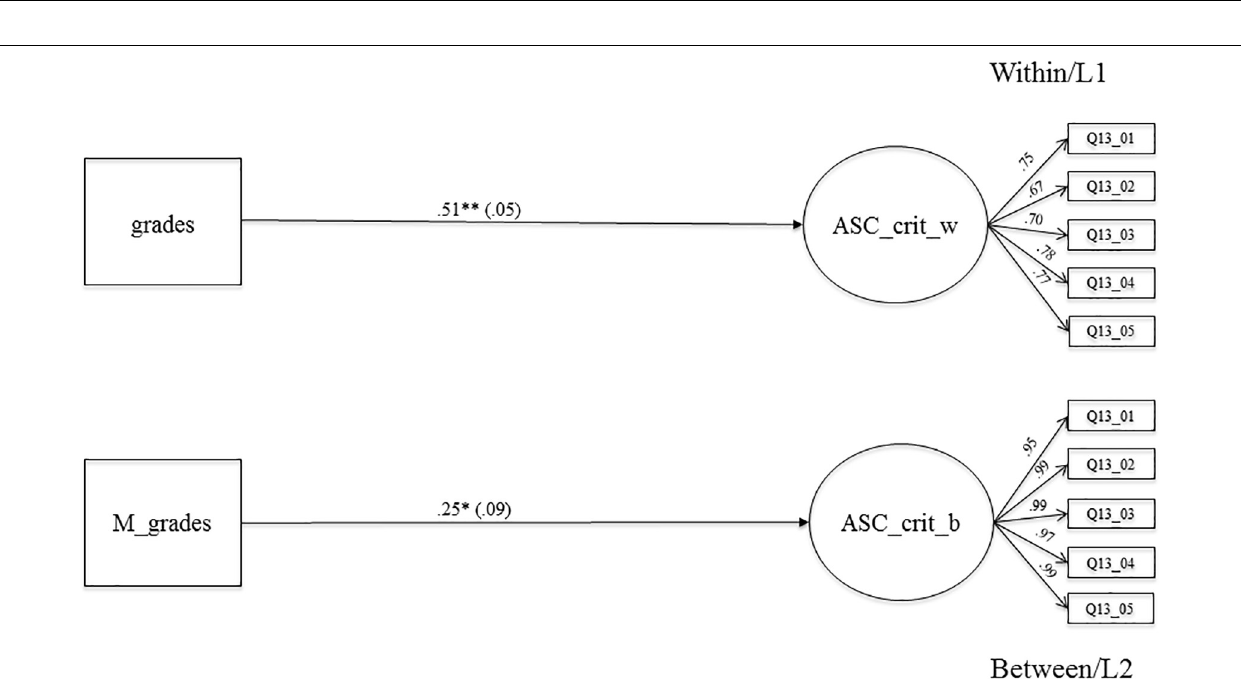
FIGURE 3 | The relationship between averaged grades in Math, German, English as a foreign language. Biology and criterial academic self-concept on the within and between level. Level 1, student level; Level 2, classroom level; regression coefficients were standardized by group-mean-centering; grades, averaged grades at the end of the school year 7 (Math, German, English as a foreign language, Biology): ASC_crit_w, criterial academic self-concept on LI (within); M_grades, aggregated mean-grades on L2; ASC_crit_b, criterial academic self-concept on L2 (between); bold pathways are significant at ∗ p < 0.05, ∗∗ p < 0.001; dotted pathways are not